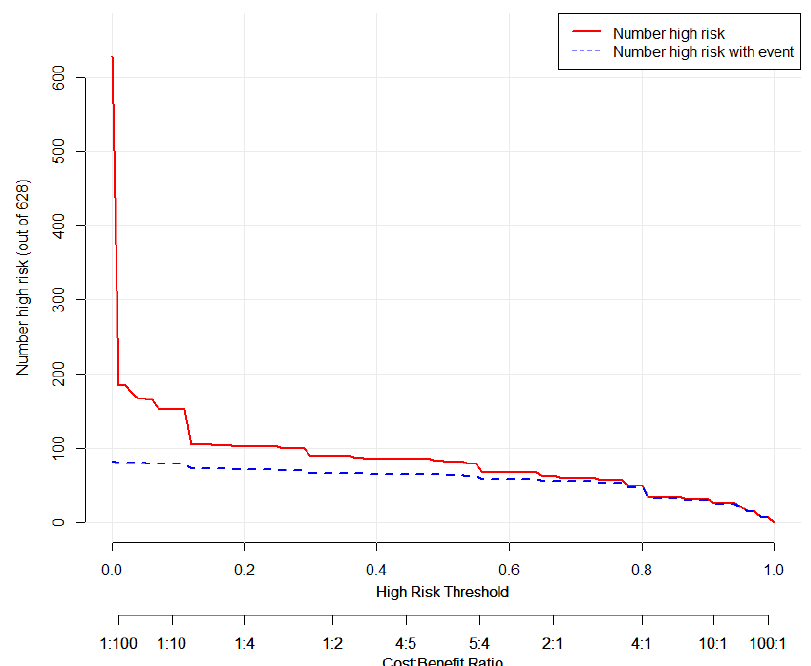
Figure 7. Plot for the clinical decision curve. The y -axis measures the net benefit. The blue line indicates the nomogram’s prediction. The thin gray line represents all patients for whom death would occur. The thick gray line represents no patients for whom death would occur. The net benefit was calculated by subtracting the proportion of all patients who were false positives from the proportion who were true positives, weighted by the relative harm of forgoing treatment compared to the negative consequences of unnecessary treatment.